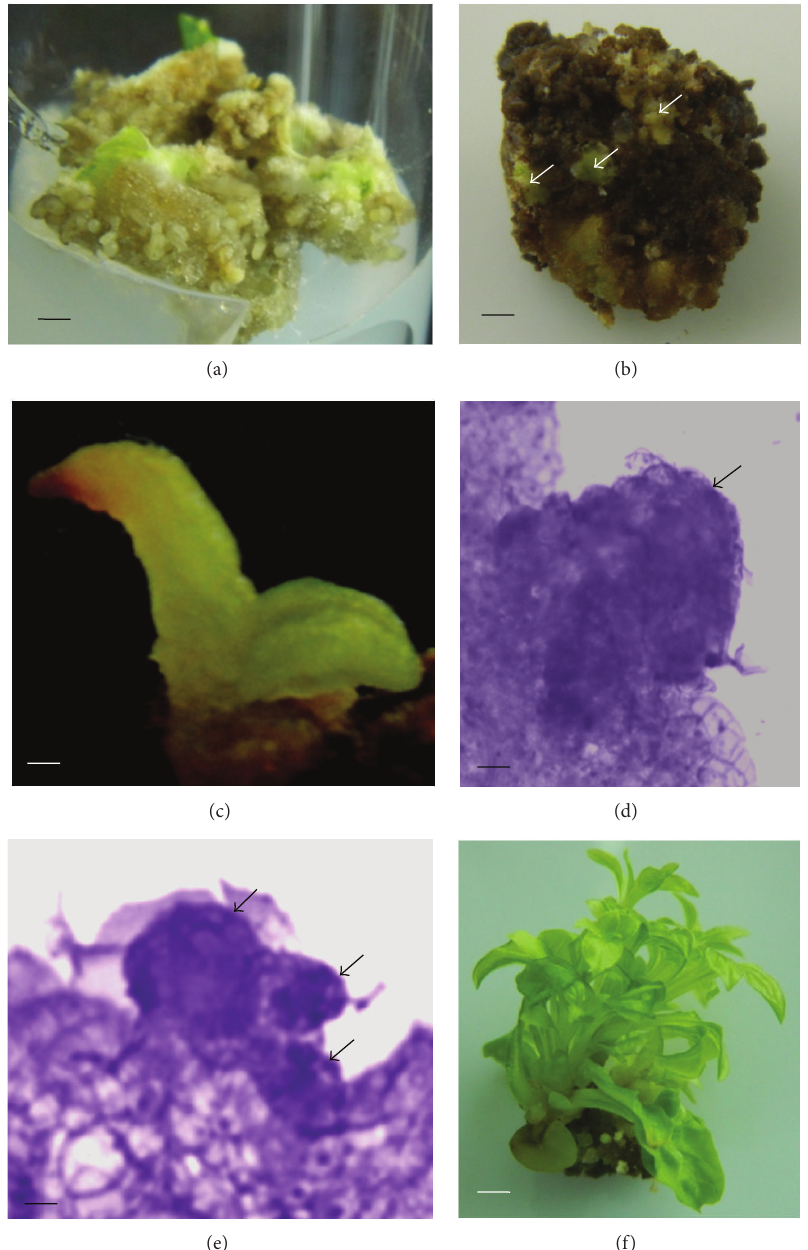
Figure 1: Direct organogenesis from leaf explants of A. lanata . (a) and (b) Initiation of adventitious shoot buds (arrowhead) from leaf explants on MS medium containing 1.0mg L −1 TDZ. (c) Development of a shoot bud after 2 weeks of culture period. (d) and (e) Leaf section shows meristematic region (arrowhead). (f) Development of shoot bud after 3 weeks of culture. Bars = 2 mm ((a), (b)), 5 mm (c), 100 𝜇 m ((d), (e)), and 2.5 cm